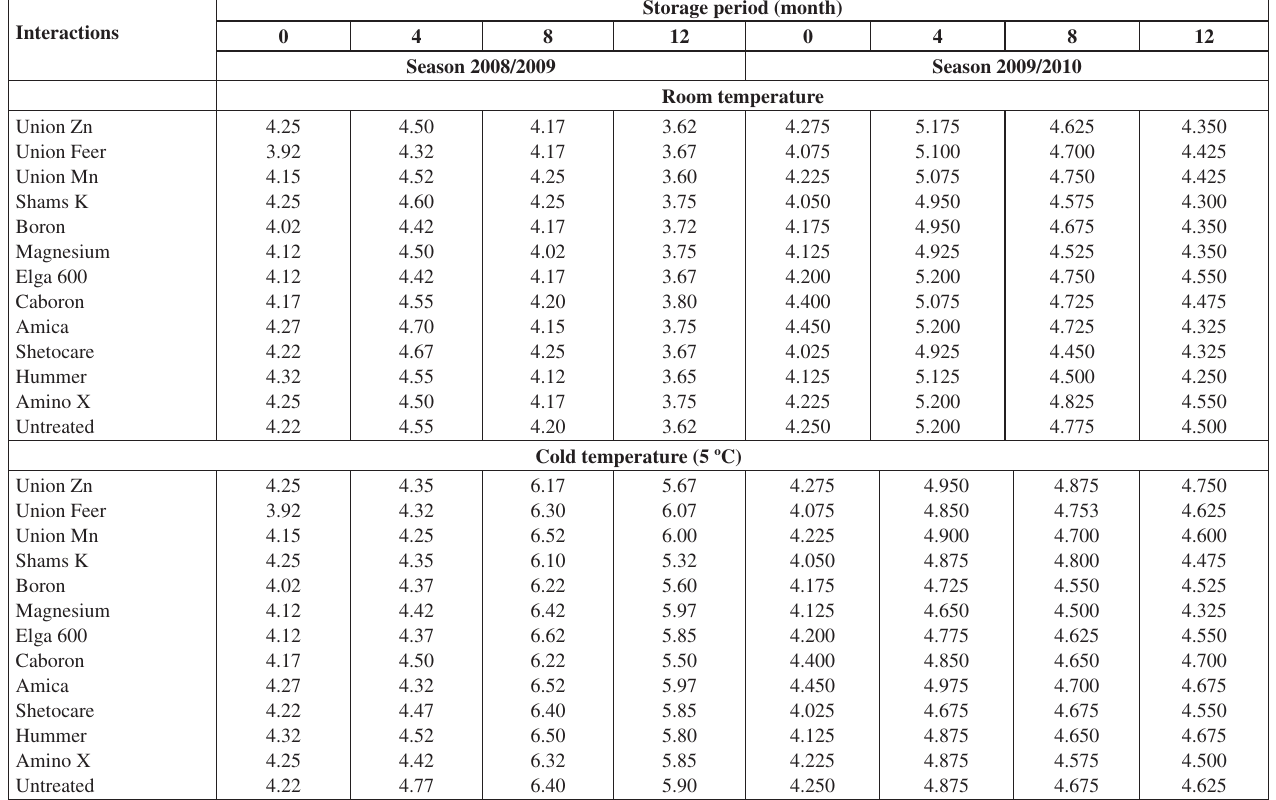
Table 14: Effect of the interaction between storage temperature, storage period and foliar application with commercial compounds on water content (%) of onion seeds during seasons of 2008/2009 and 2009/2010